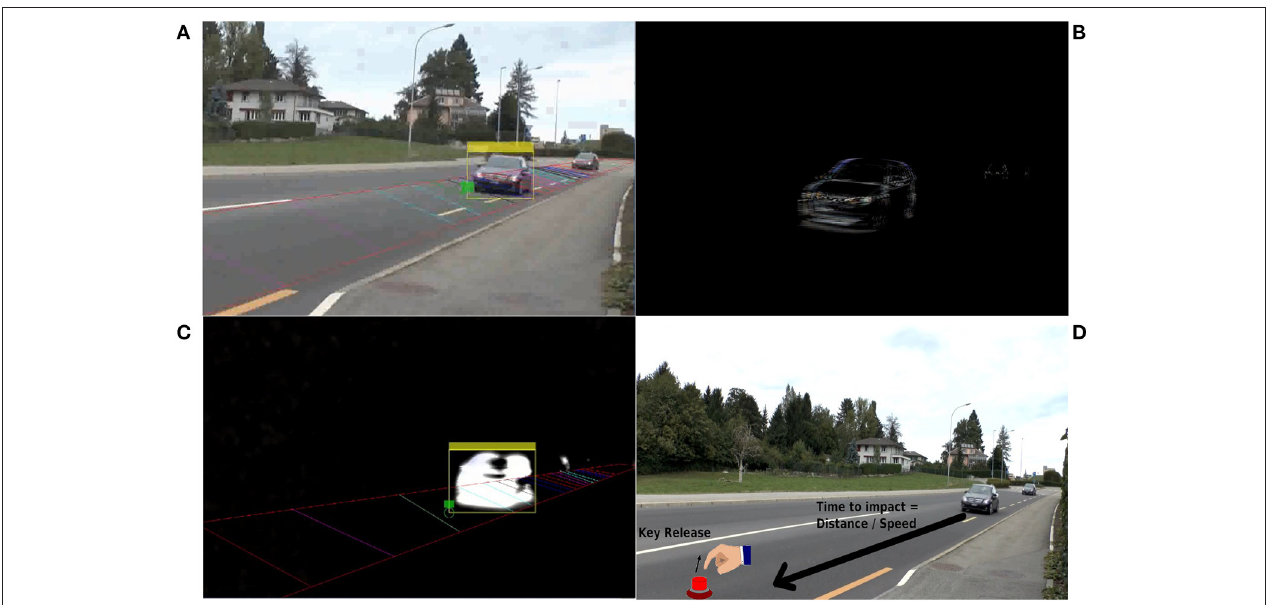
FIGURE 1 | Illustration and description of the car detection algorithm. (A) Screenshot of the car detection algorithm on original stimuli. Colored markers on the road indicate where car distance is calculated. (B) Difference video. (C) Difference video features magnified by the Eulerian magnification with results of the car detection algorithm. (D) Illustration of the time to impact measure. Description of algorithm: Our method uses a foreground detector via Gaussian mixture models (Kingdom, 2017) then performs a Blob Analysis on the detected foreground objects. We then applied a Kalman filter (Kingdom, 2019) to reduce the number of times the objects were lost (A) . To further improve the performance of the foreground detector we created difference videos from the stimuli videos. In the difference videos, each frame was created by subtracting the previous frame in the original video from the current one (B) . Moreover, the motion in each difference video was enhanced using the Eulerian magnification toolbox (Wu et al., 2012). We amplified the motion so that the vehicles blurred into one very bright object—including larger vehicles (such as trucks) which would often be detected as two objects by the car detection algorithm (C) . A marker was then placed in the video at known distances along the